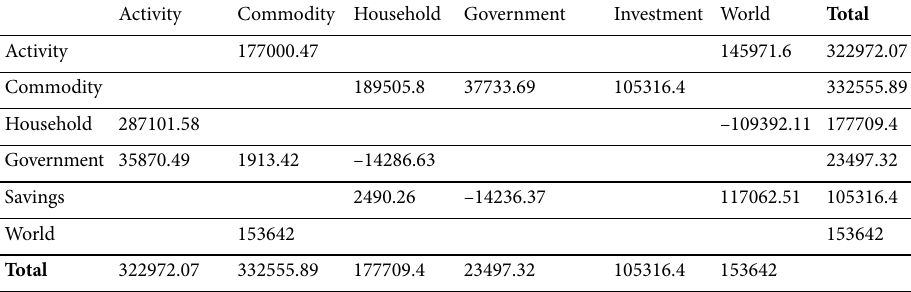
table 2. numerical social accounting matrix for Croatian economy for